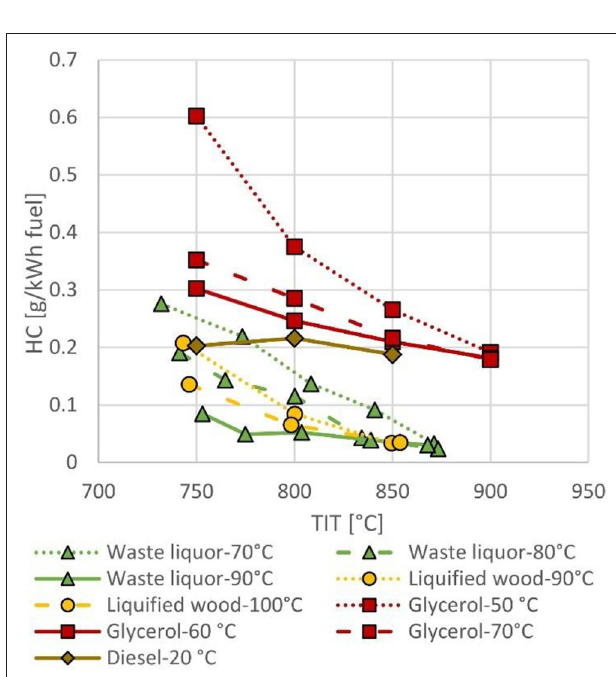
FIGURE 11 | HC emissions for different fuels at different fuel temperatures.